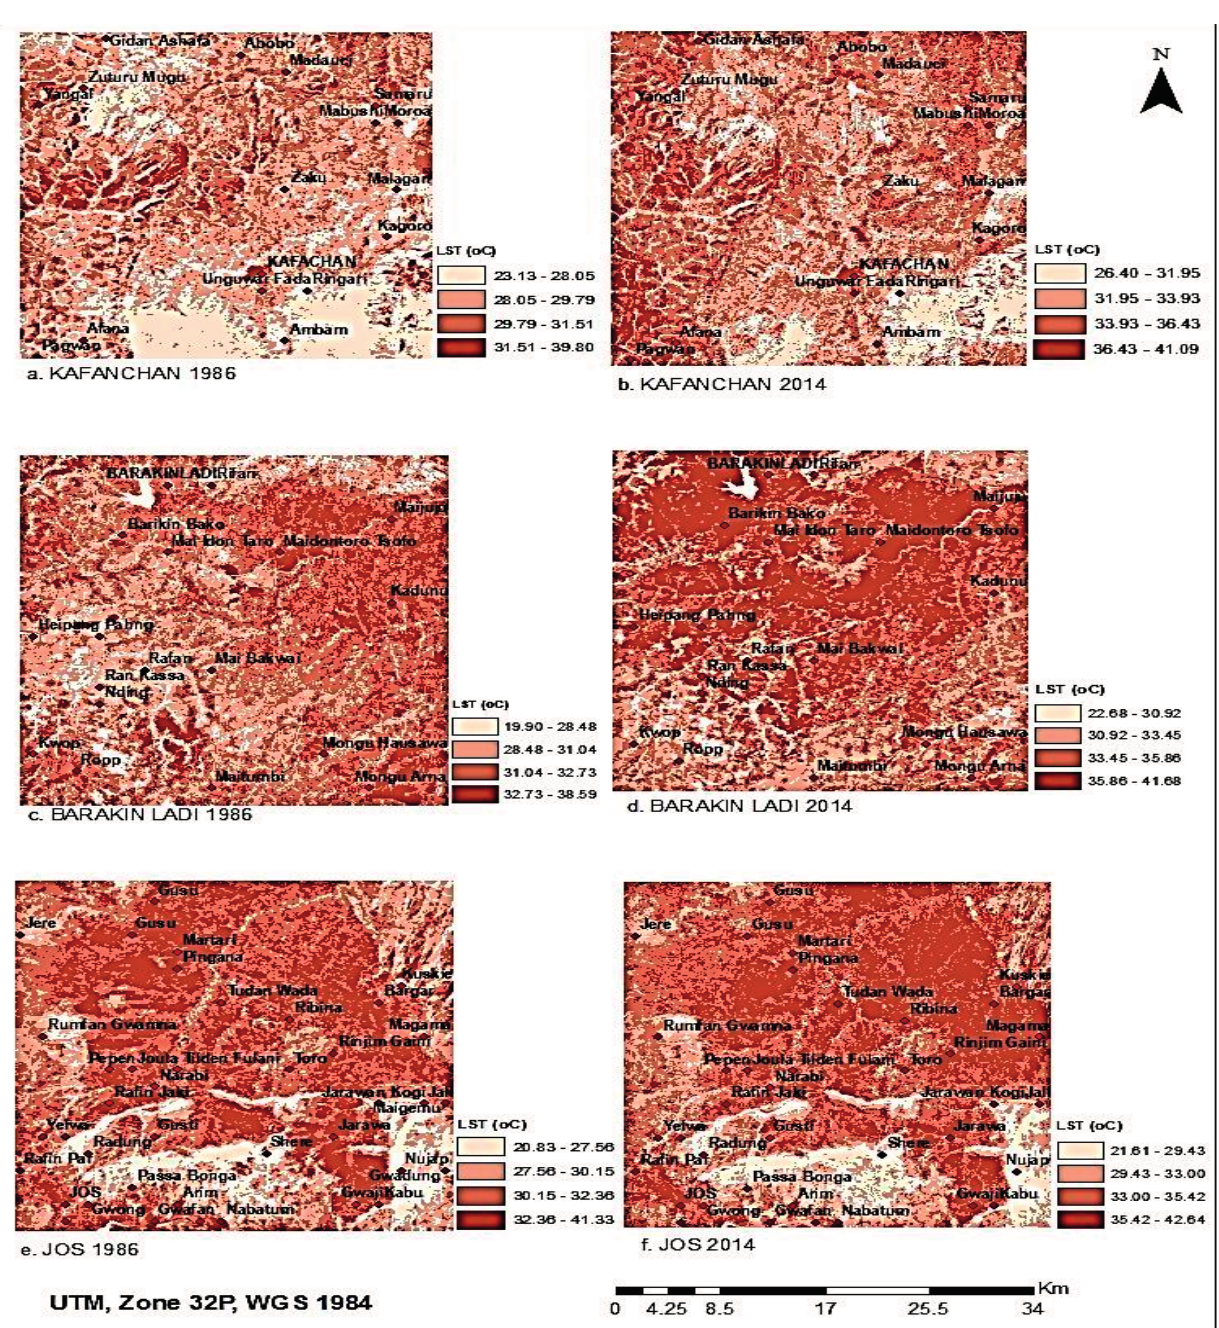
Figure 5. LST change in the three